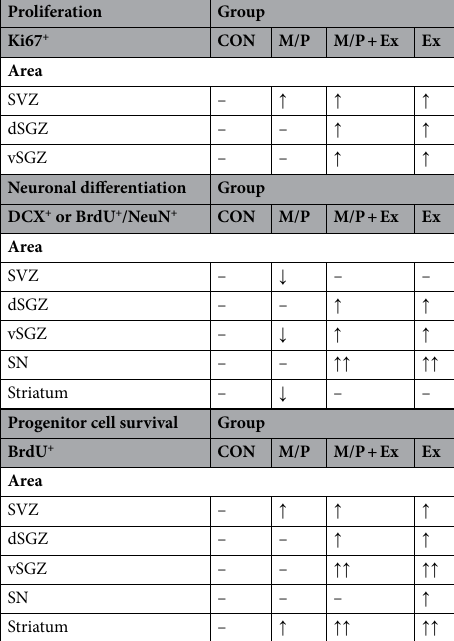
Table 1. Summary of the proliferation, neuronal differentiation, and survival capacity of neural precursor cells in response to M/P and/or rotarod walking exercise. (–: basal levels, ↑ : 1.5–twofold increase, ↑↑ : increase more than twofold, ↓ : 1.5 fold